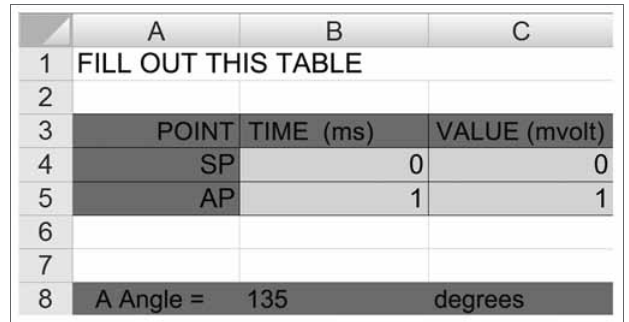
Figure 1. Excel® spreadsheet used to calculate the angular measure. After filling out the green fields with the latency and amplitude values we obtain the angle